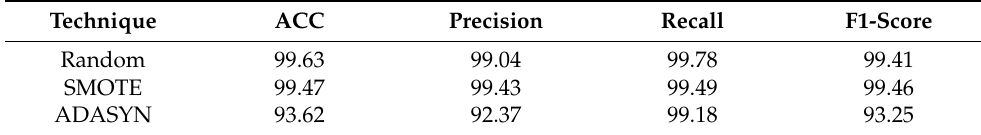
Table 10. Evaluation metrics for the CICIDS2017 dataset with oversampling.